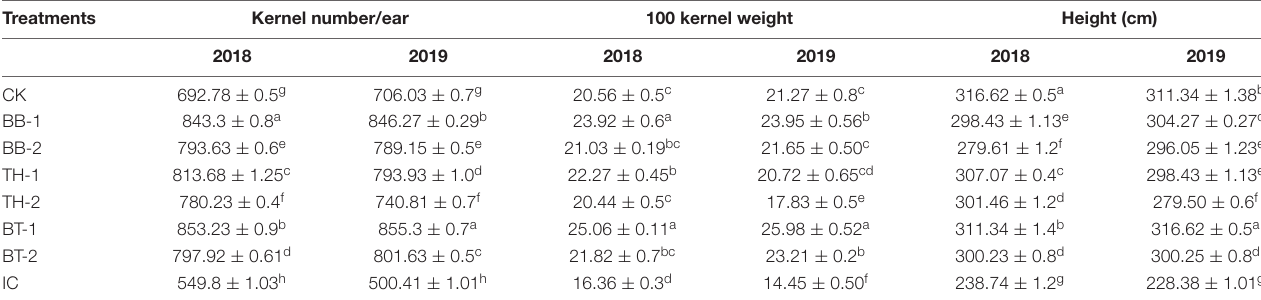
TABLE 3 | Differential effect of single and consortium of B. bassiana OFDH1-5 and T. asperellum GDFS1009 inoculation on maize yield under O. furnacalis attack in 2018 and 2019. Treatments